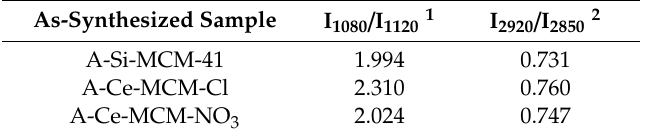
Table 2. Template assembly disorder for the as-synthesized MCM-41